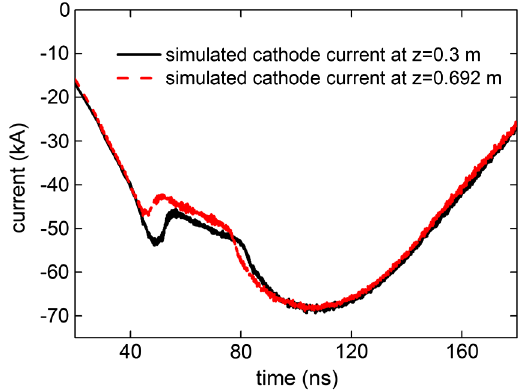
FIG. 12. Simulated cathode currents at z ¼ 0 : 3 m and z ¼ 0 : 692 m . Inferring from the curves, electron emission starts earlier at downstream of the support, which is believed to be resulted from field enhancement at the contact area of helical and MITL cathode. Inflexion around 70 ns suggests effective mag- netic insulation starts to establish.